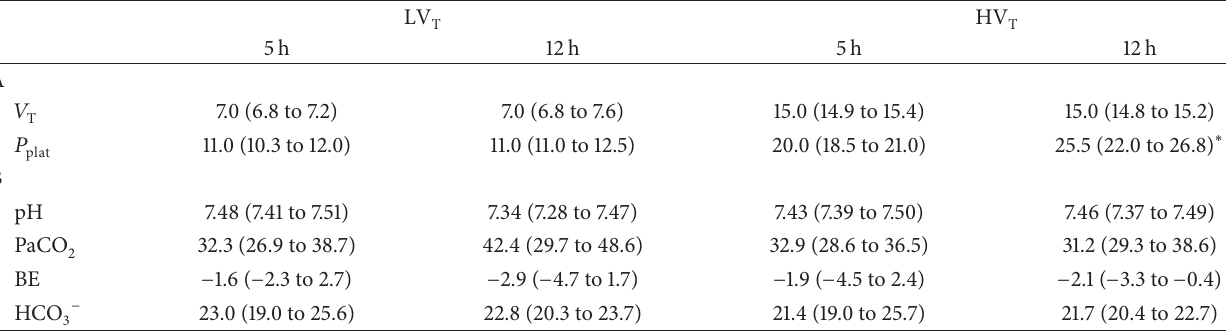
Table 1: Ventilator settings and arterial blood gas analysis.